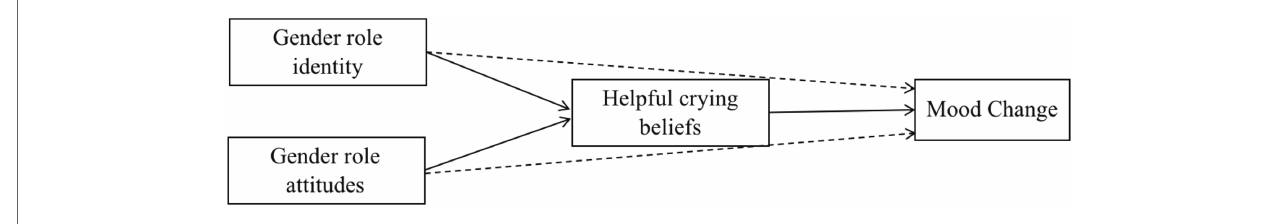
FIGURE 1 | Model of predicted pathways between gender roles, beliefs about crying (BACS), and crying